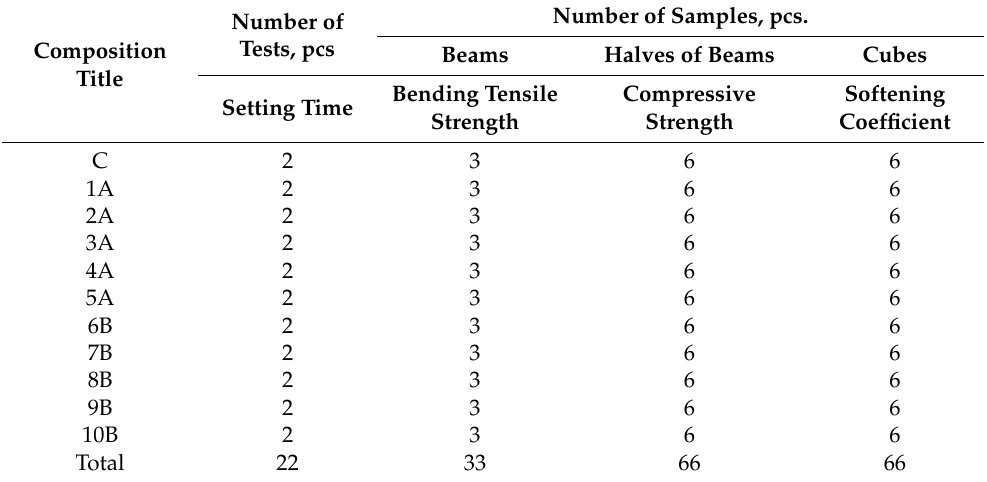
Table 8. Number of tests and samples of geopolymer